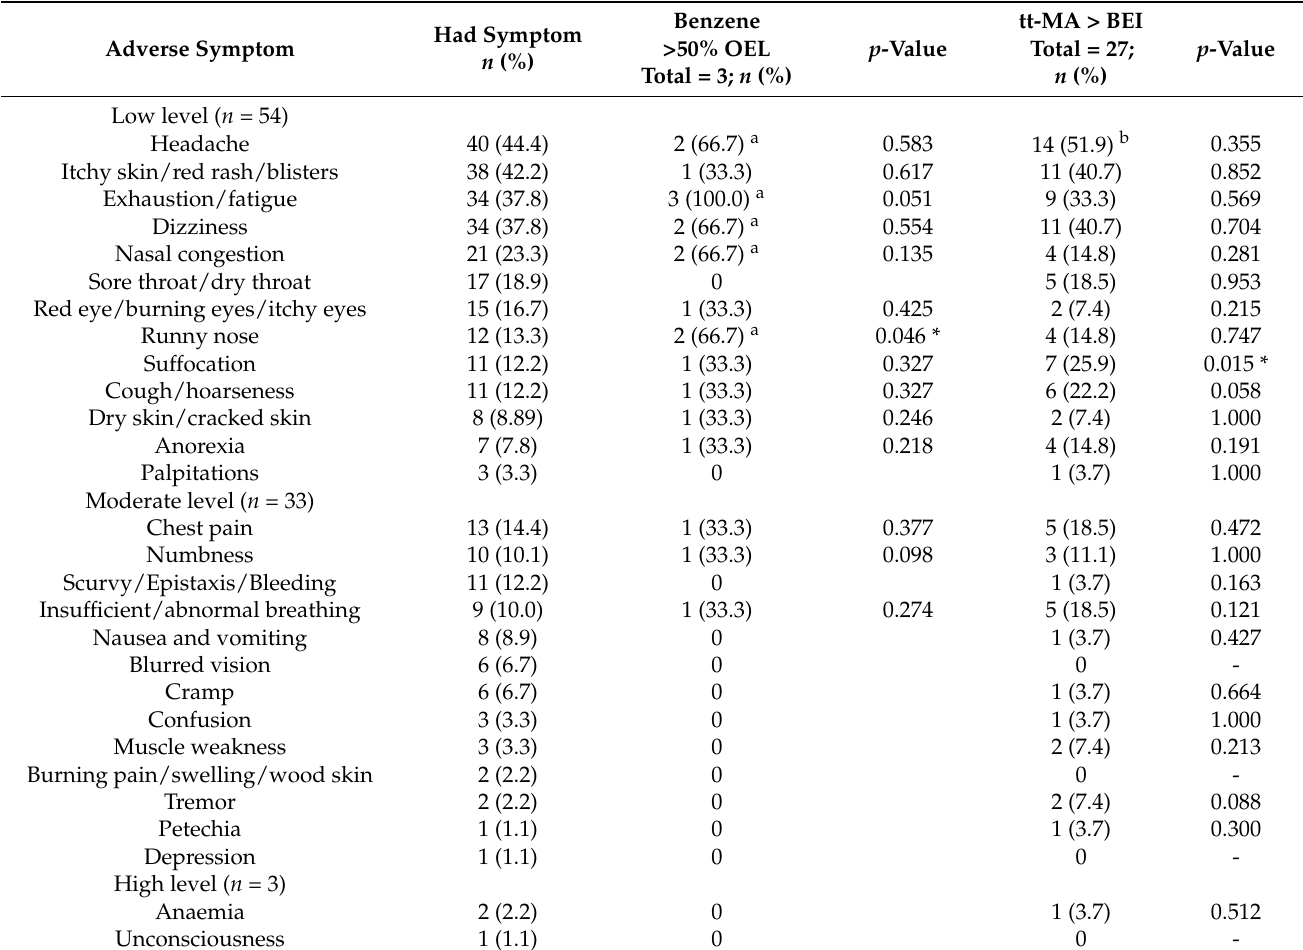
Table 1. Adverse health effects of benzene exposure ( n =